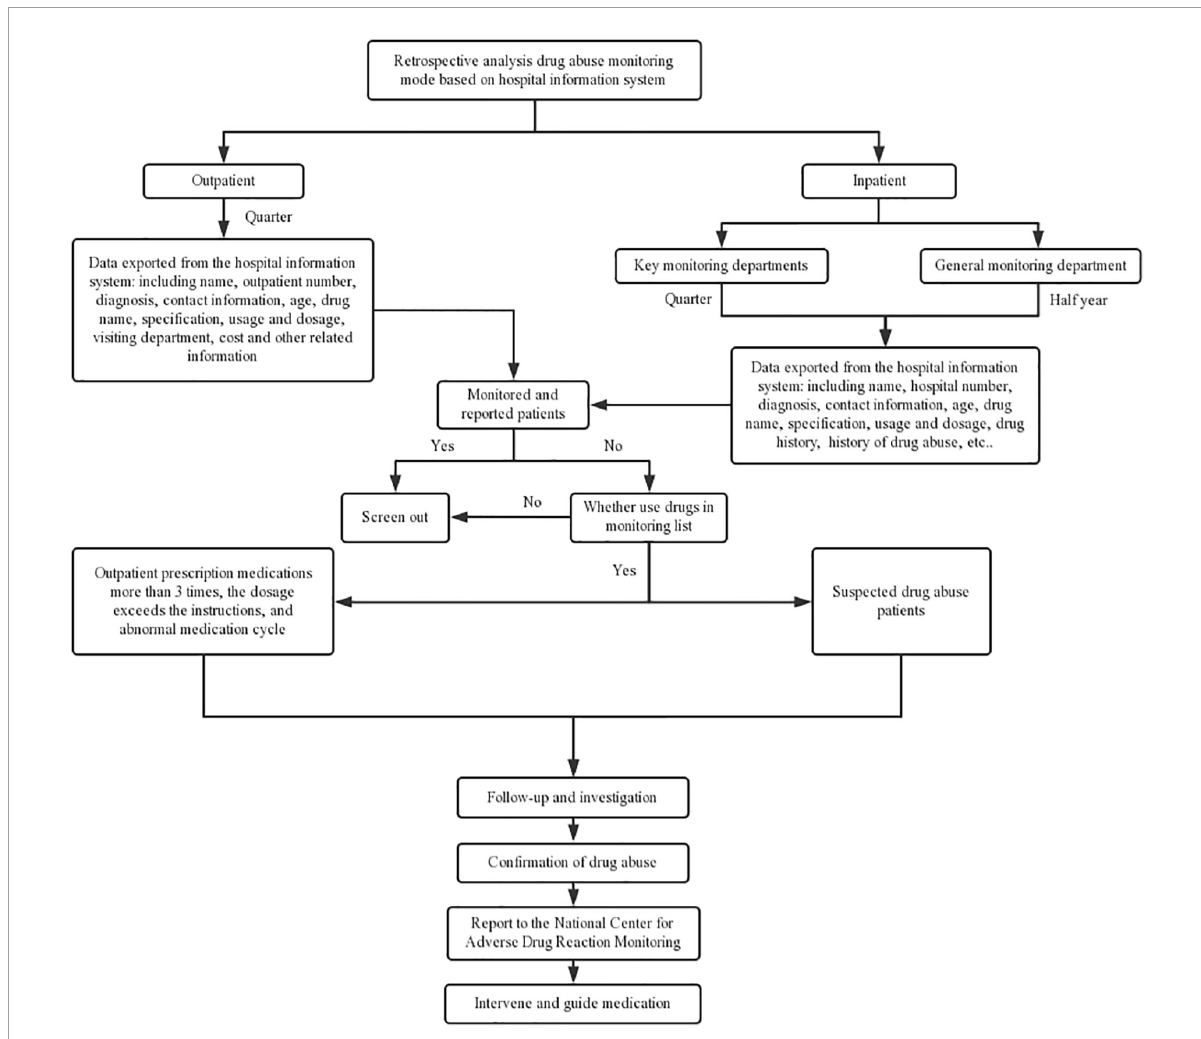
FIGURE2 Details of retrospective PMA monitoring